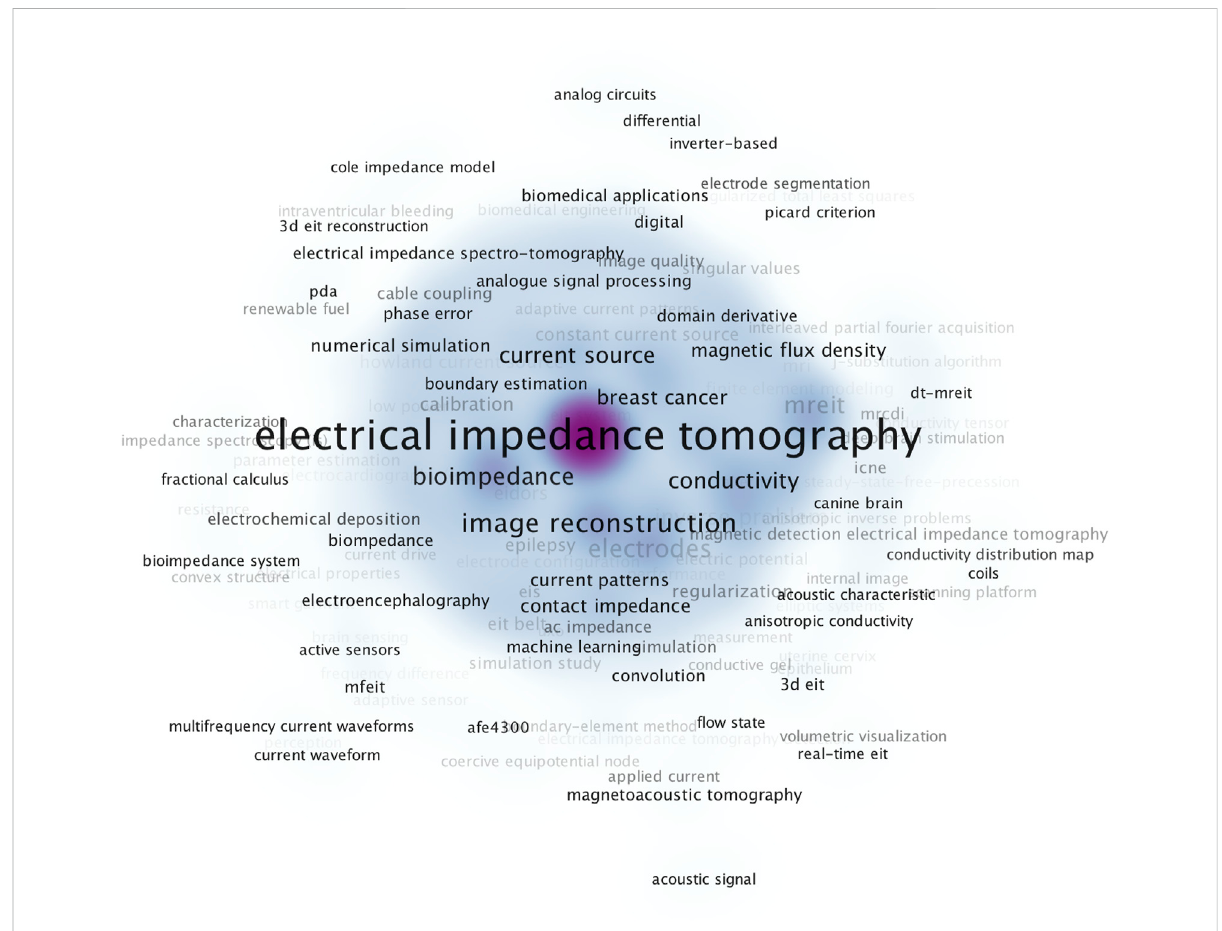
FIGURE 4 VisualizationmapofkeywordsdensityonEIThardwareresearchfrom1989.01.01to2021.12.31.Thelabelindicateskeywords,thereducedcolor from purple to white indicates density of each keyword calculated by frequency of